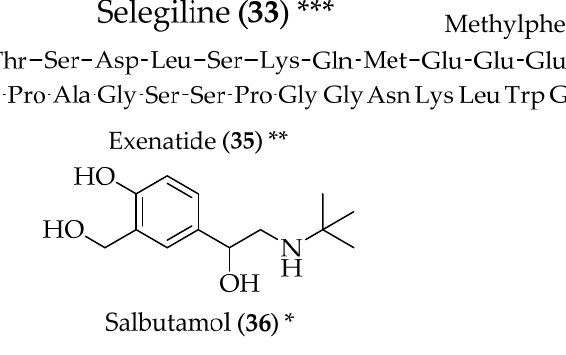
Figure 3. Structure of drugs 30 – 36 (*) Preclinical Studies; (**) Under clinical studies; (***) Clinically approved.